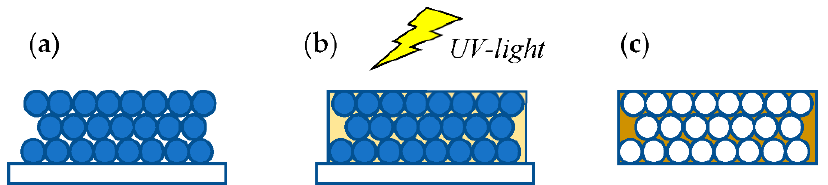
Figure 2. Schematic of MIPs fabrication: ( a ) colloidal crystal on a glass substrate; ( b ) infiltration with pre-polymerization solution and UV-polymerization; ( c ) porous film after etching of sacrificial particles and substrate by acid and target elution.